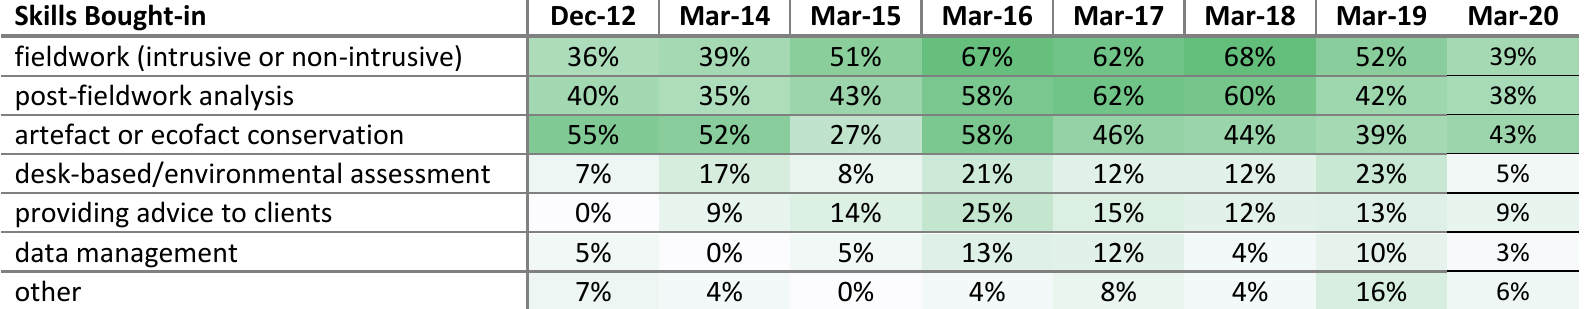
Table 22: Skills bought-in from 2012 to 2020. Percentages calculated on total responses to all skills questions and not just those to this specific question. The assumption is made that those who did not respond did so because they had no need to buy in the